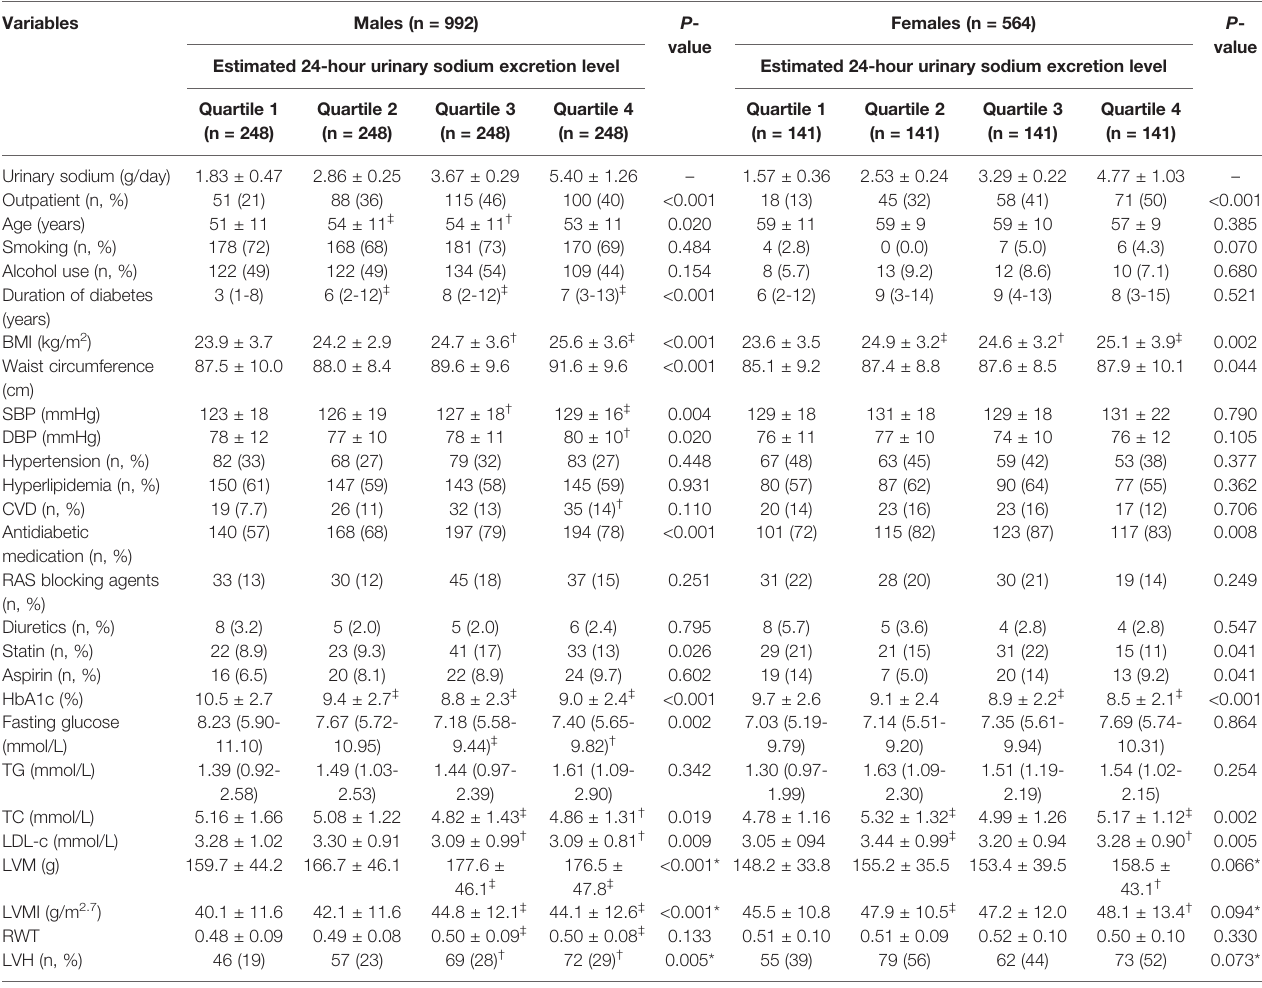
TABLE 2 | Characteristics of individuals categorized by quartile of urinary sodium excretion and gender. Variables